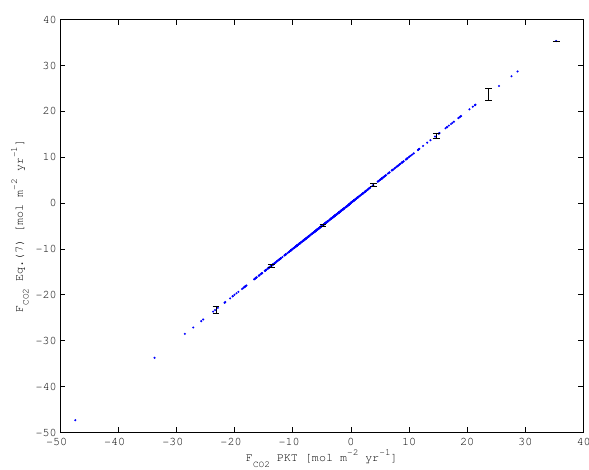
Fig. 9. Scatter plot of the results from Eq. (7) against the results of the PKT correction for IRGA wetB , individual (blue) and binned